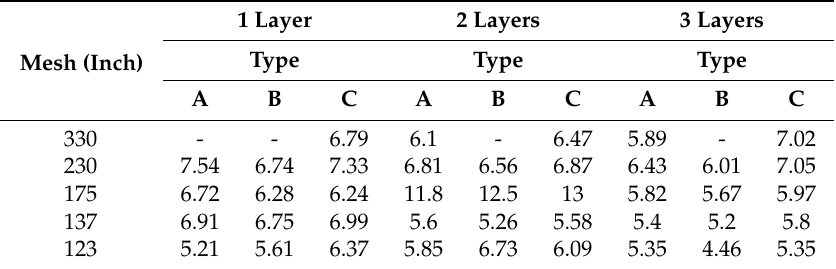
Table 4. Capacitance (pF) for TLD when 1–3 layers of D2081009D6 ink are used.